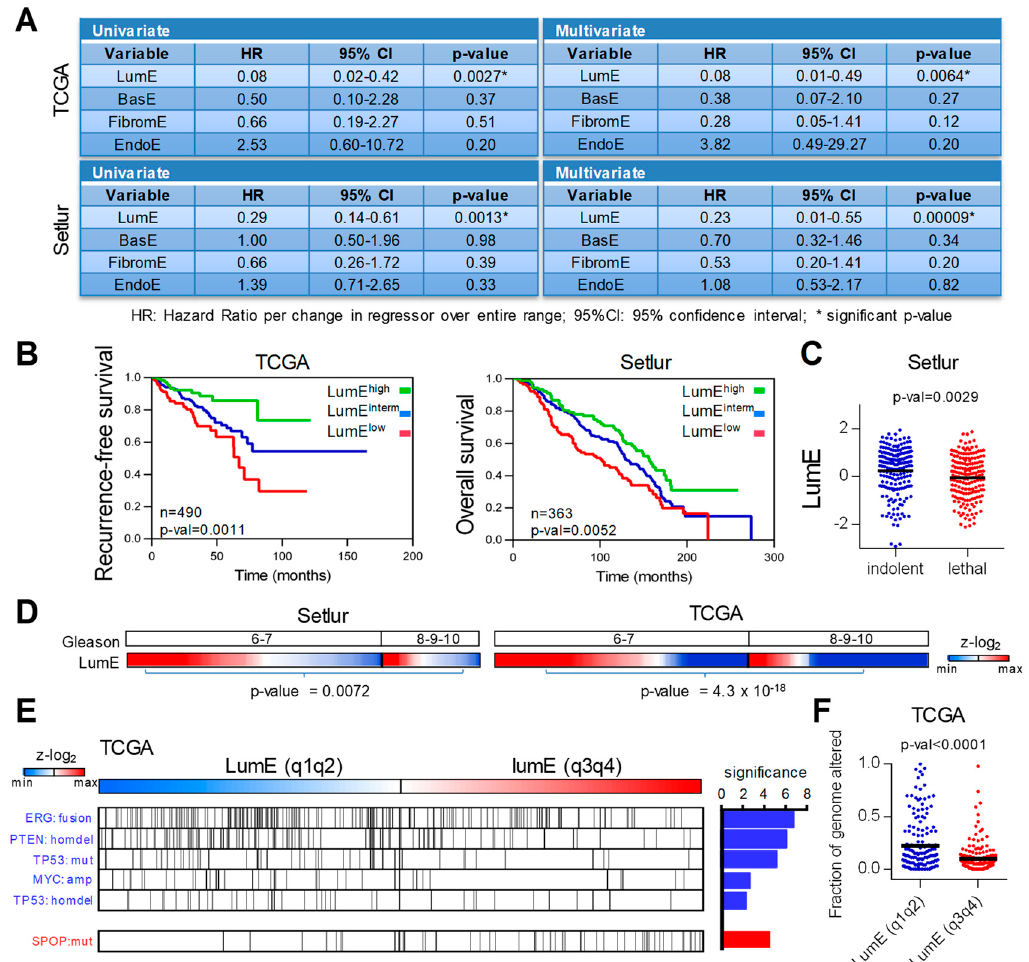
Figure 2. Luminal metagene is associated with aggressive features and poor prognosis. ( A ) Univariate and multivariate Cox regression analysis in the TCGA and Setlur datasets (recurrence-free survival and overall survival, respectively) using LumE, BasE, FibromE, and EndoE metagene scores. LumE is significantly associated with poor prognosis in both cohorts. Association with other metagenes was not significant. ( B ) Kaplan–Meyer analysis of recurrence-free survival (TCGA) and overall survival (Setlur) based on LumE score. Patients were allocated in 3 groups depending on score values: LumE low (quartile q1), LumE intermed (quartiles q2 and q3), and LumE high (quartile q4). ( C ) Comparison of LumE scores in indolent and lethal prostate tumors in the Setlur dataset. P-value calculated with t -test. ( D ) Correlation between LumE and Gleason scores in Setlur and TCGA datasets. High Gleason samples display significantly lower LumE scores in both cohorts. P-values calculated with t -test. ( E ) TCGA samples with lower LumE scores (quartiles q1 and q2) display more genetic alterations than those having higher scores (quartiles q2 and q4). Significant di ff erences were calculated with Fisher’s exact test (threshold p -value < 0.01). Significance: − log 10 ( p -value). Blue bars: more alterations in LumE q1q2. Red bar: more alterations in LumE q3q4. ( F ) Association between luminal score and fraction of genome altered in TCGA dataset. Samples with lower LumE scores (q1q2) display higher fraction of genome altered than higher LumE scores (q3q4). Metagene enrichment scores are shown at the z-log 2 scale.